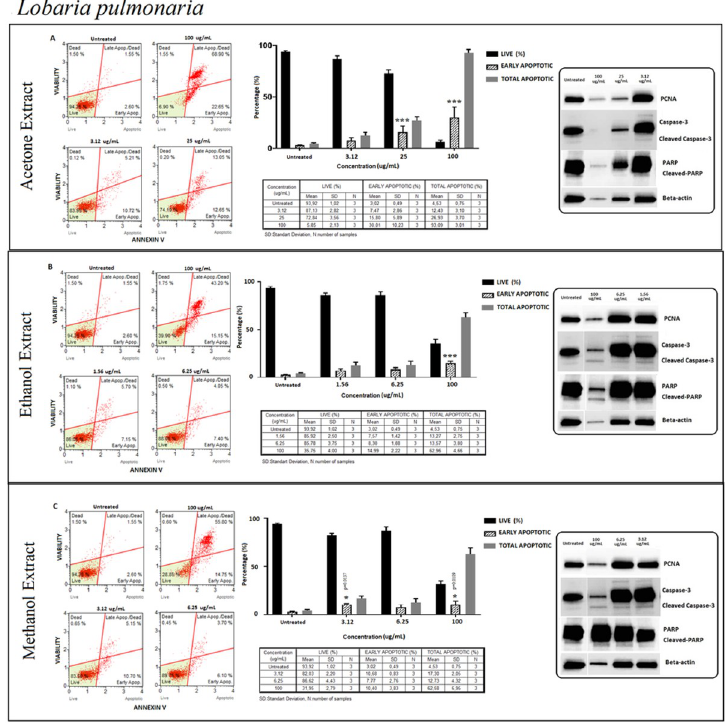
Fig 9. Lobaria pulmonaria (LP); Annexin V/7’AAD staining flow cytometry results (scatterplots), statistical analysis (bar graphs), ± SD changes between experiments (tables) and protein levels of PCNA, caspase-3 and PARP by western blot (right panel) on PC-3 cells with three different extraction of acetone (results compiled in A), ethanol (results compiled in B) and methanol (results compiled in C) respectively. Annexin V/7’AAD staining by flow cytometry of LP on PC-3 cells was shown to induce apoptotic cell death by mainly early apoptosis. The gating was adjusted according to the untreated sample and the representative scatterplots were presented as the percentage of cells that were viable (Ann-V − and 7-AAD − ), early apoptotic (Ann-V + and 7-AAD − ), late apoptotic (Ann-V + and 7-AAD − ), and dead (Ann- V − and 7-AAD + ). Scatterplots are shown for untreated, 100 μ g/mL, 25 μ g/mL and 3.12 μ g/mL after 72 hours treatment with acetone extract (A) and for ethanol extract treatment, groups are untreated, 100 μ g/mL, 6.25 μ g/mL and 1.56 μ g/ mL after 72 hours treatment (B) and for methanol extract treatment, groups are untreated, 100 μ g/mL, 6.25 μ g/mL and 3.12 μ g/mL after 72 hours treatment (C) respectively. The 100 μ g/mL concentration is determined as toxic dose for all treatment groups. Results were analyzed and presented as the percentage of three independent experiments of live, early apoptotic and total apoptotic after treatment (bar graphs). Flow cytometry was shown to induce apoptotic cell death by mainly early apoptosis. The significance of only early apoptosis for each concentration indicated with an asterisk and the p value was only presented when the significance level of early apoptosis rate between 0.05 and 0.01. ± SD changes between apoptosis assays were indicated as the mean value and SD changes per concentration and per group of live-early apoptotic-total apoptotic separately (table). Western blot results of proliferating cell marker PCNA and apoptosis-related proteins (right panel) were presented. Dose-dependent PCNA, cleavage of caspase-3 and, PARP respectively. Apoptosis rate seems increased significantly by treatment with specified concentrations by flow cytometry however western blot data showed otherwise for cleaved-caspase-3 and PARP respectively when compared with untreated group. In addition, the proliferation (PCNA) status; decreased with higher concentrations of acetone extract, and significantly increased by ethanol extract. Yet methanol extracts remained stable with specified concentration when compared with untreated group. � p < 0 . 05 , �� p < 0 . 001 , ��� p < 0 . 0001 (all p-values were obtained by two-way ANOVA following Dunnet’s multiple comparison